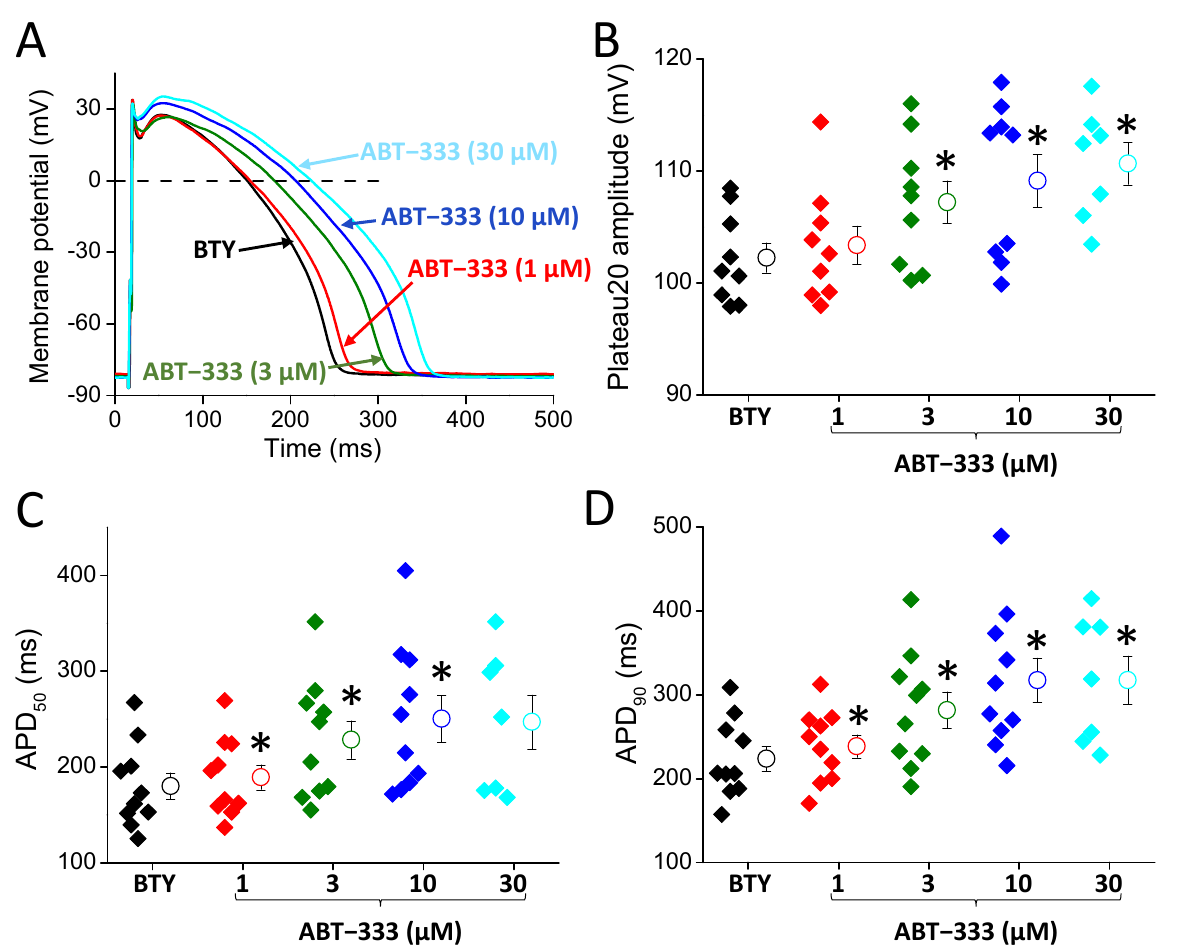
Figure 3. Effects of 1–30 µ M ABT-333 on left ventricular AP. ( A ) Representative action potentials. The black trace is the AP measured in BTY (control solution), the color-coded ones are in the presence of increasing ABT-333 concentrations. ( B – D ) Diagrams showing AP parameters in the control condition (black) and in the presence of ABT-333 (various concentrations using color coding) where filled diamond symbols, circles, and whiskers show the individual values, means, and ± SEM, respectively. Values of early phase plateau amplitude (plateau20 amplitude, ( B )), action potential duration measured at 50% of repolarization (APD 50 , ( C )), and action potential duration measured at 90% of repolarization (APD 90 , ( D )), obtained in 10 cells from 7 animals, except in 30 µ M ABT-333, where it was 7 cells from 6 animals. Asterisks show statistically significant difference from control ( p < 0.05). ABT-333 also reduced the maximal rate depolarization (phase 0; V + max), maximal rate of early repolarization (phase 1; V Ph1 max), and maximal rate of terminal repolarization (phase 3; V − max). Only 10 and 30 µ M ABT-333 decreased V + max significantly to 84.4 ± 6.2 and 77.8 ± 10.9% of the control, respectively. Higher ABT-333 concentrations also reduced V − max values to 95.1 ± 0.9, 87.1 ± 4.2, and 84.4 ± 5.6% of the